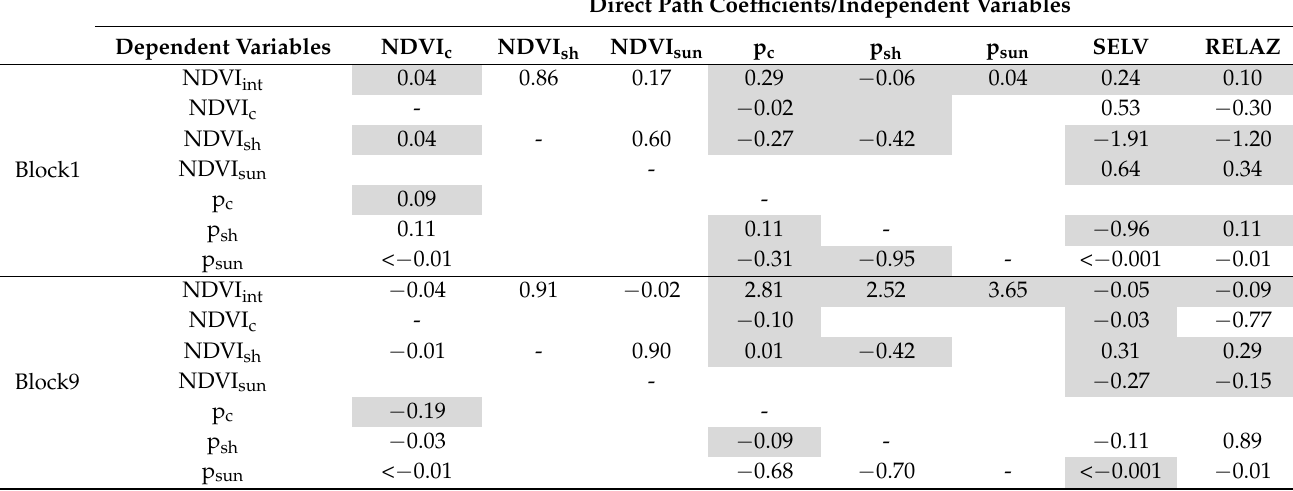
Cells shaded in grey denote relationships that are compensated by indirect effects through other variables leading to correlations with p -values larger than